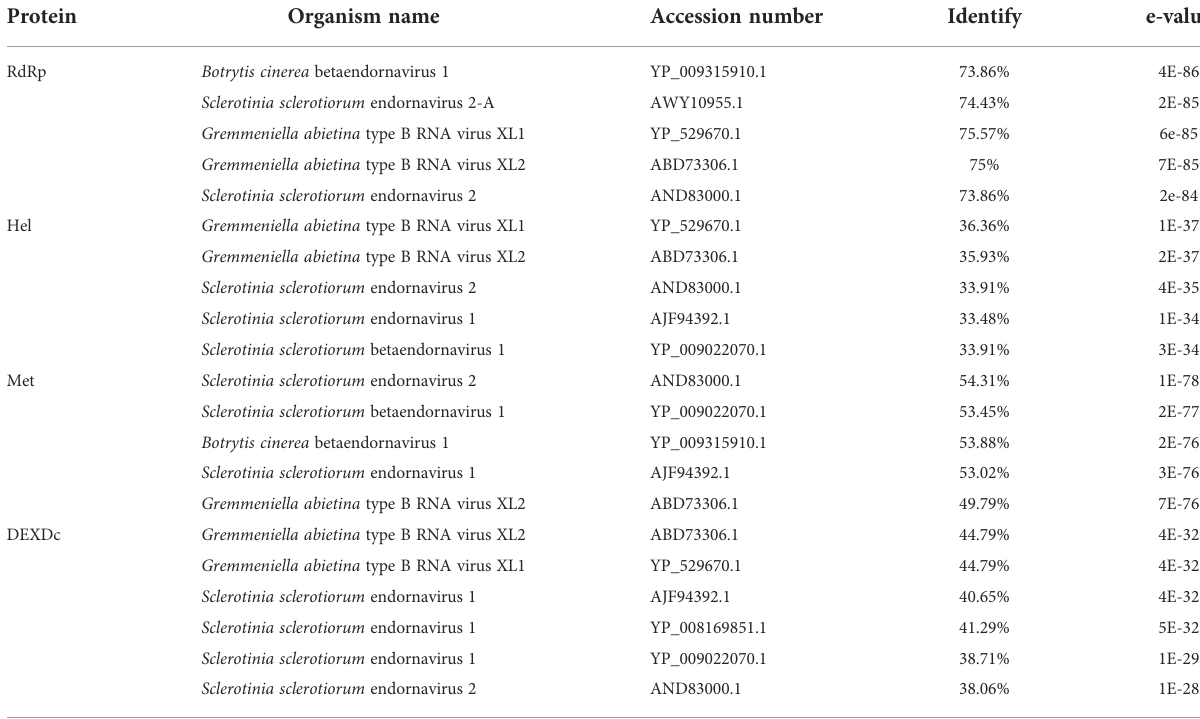
TABLE 2 Percent aa sequence identity of the 2 conserved domains of P. vexans endornavirus compared with those of other